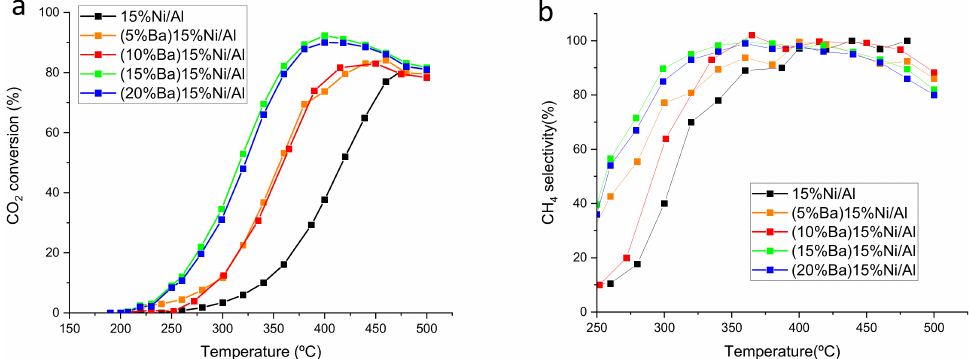
Figure 4. Effect of the amount of Ba added to 15%Ni/Al: ( a ) CO 2 conversion; ( b ) Selectivity to CH 4